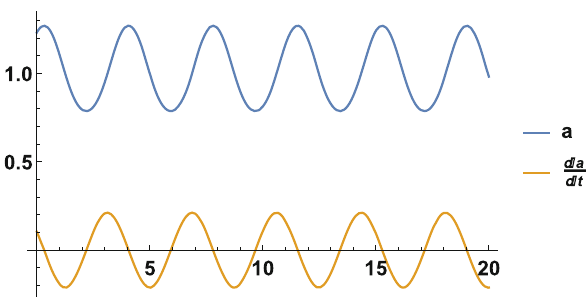
Fig. 7 Dynamicsofsystem (39)–(40)forthechoice β = 2 b 0 . 06